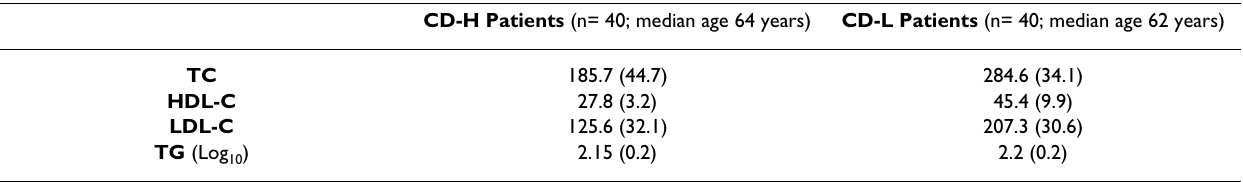
Table 2: Lipidemic parameters (mg/dL) in the samples of CD patients (46–80 years age range). Mean values with standard deviation in